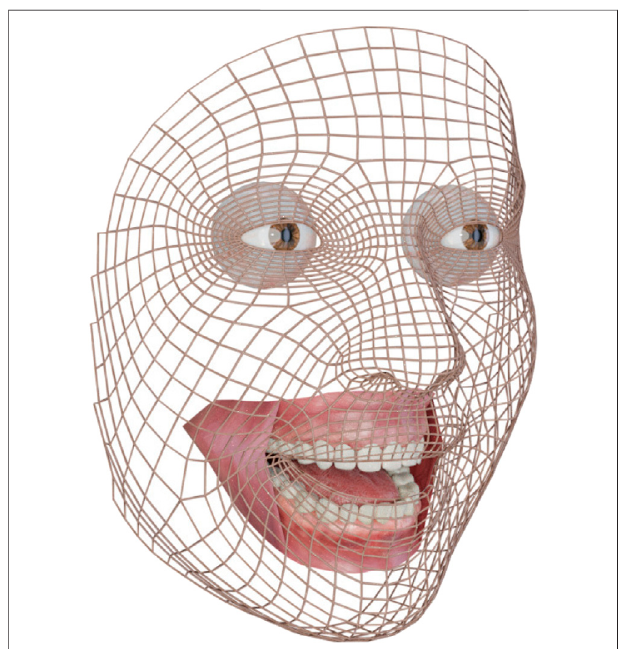
Frontiers in Virtual Reality |